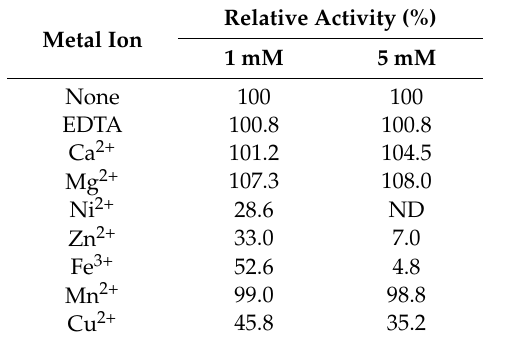
Table 2. Effect of metal ions on SpG6PD1 activity. EDTA: ethylenediaminetetraacetic acid. Metal